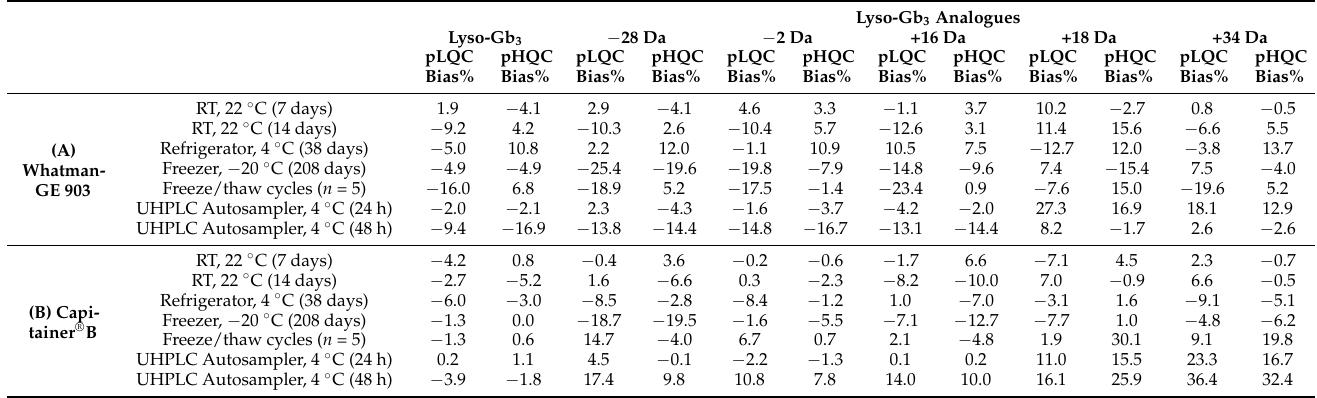
Table 8. Stability assays ( n = 2) performed with dried blood spots (DBSs) from Fabry patients as quality controls (pQCs).